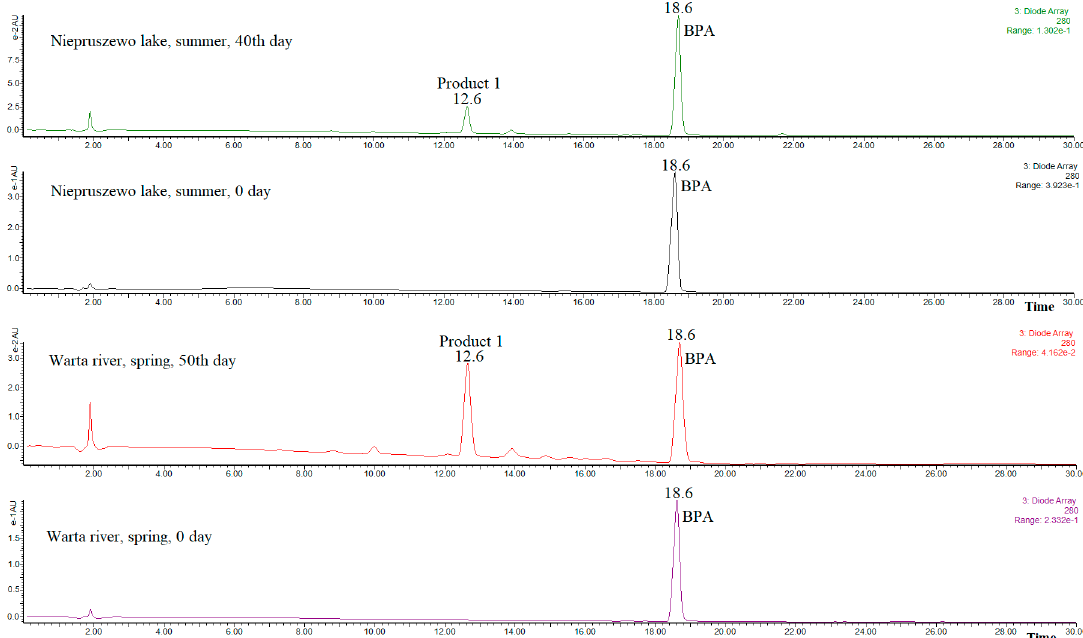
Figure 1. Exemplary UV chromatograms obtained at 280 nm (acidified gradient). Exemplary breakdown plots of chromatographic peak areas (chromatograms ob- tained at 280 nm) against days of biodegradation test are presented in Figure 2. The peak areas expressed in arbitrary units were converted into percentages (the largest peak is assumed as 100%).